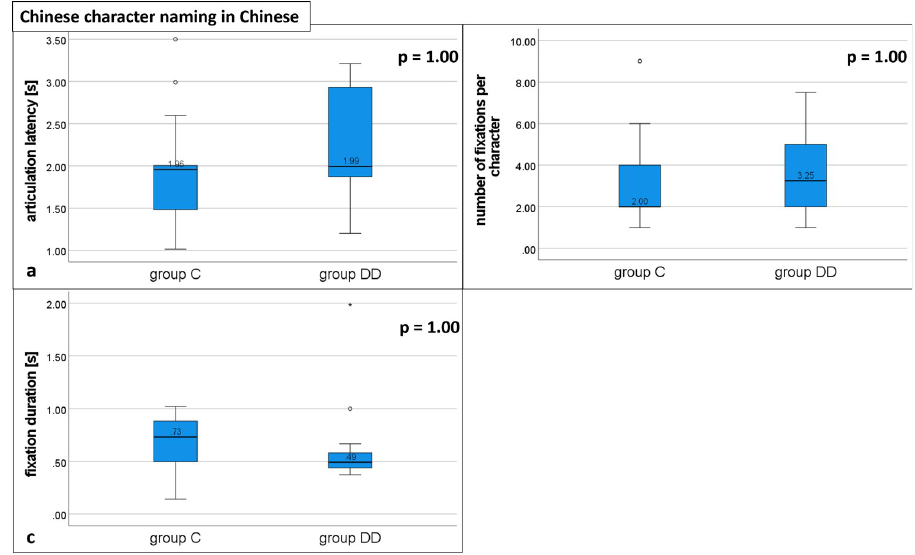
Fig 6. Eye movement variables during naming Chinese characters in Chinese: Distribution of group DD and group C. Medians for a) articulation latency, b) number of fixations, and c) fixation duration; p = probability value. No statistically significant differences for all three variables. See Table 2 for